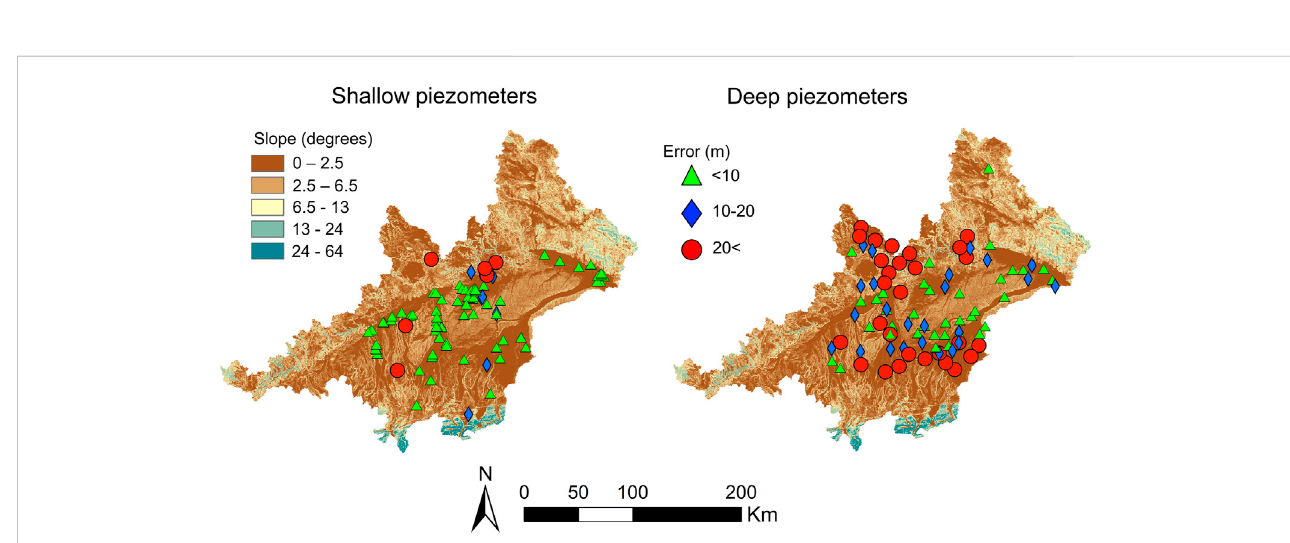
FIGURE 7 Residual error at the observation points obtained with the steady state calibration for shallow (right) and deep (left) piezometers. Results are shown on a surface slope map to show how the slope in fl uences the residual error.